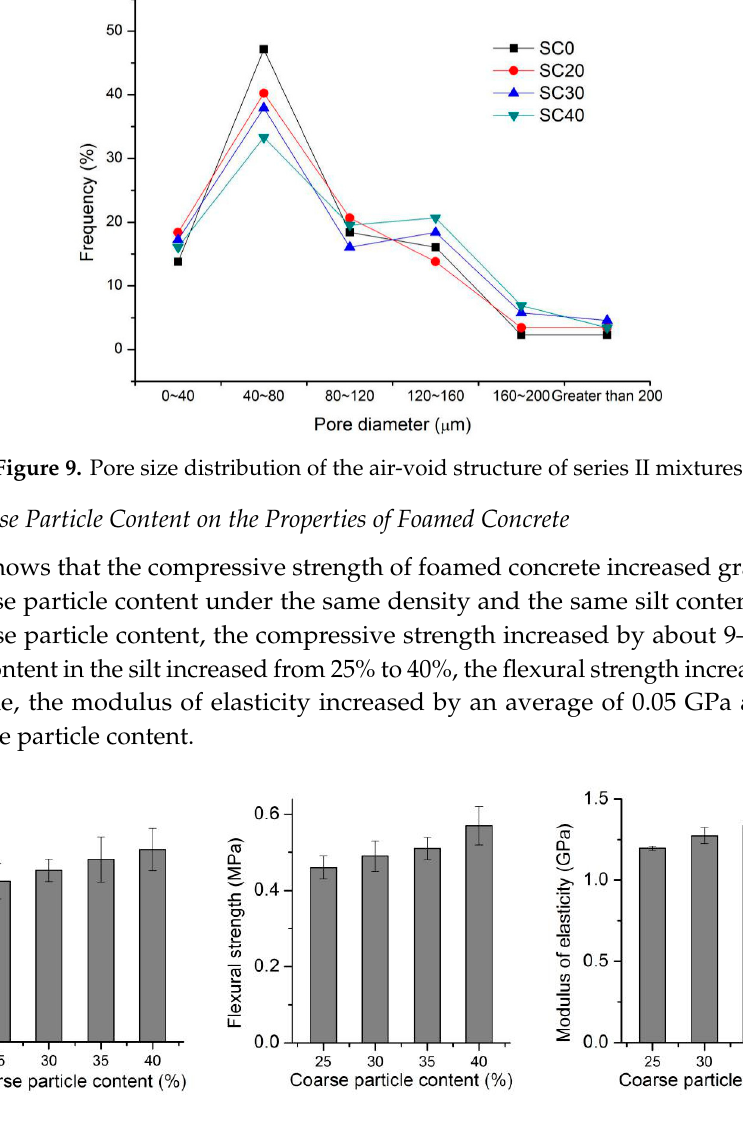
Figure 9. Pore size distribution of the air-void structure of series II mixtures.